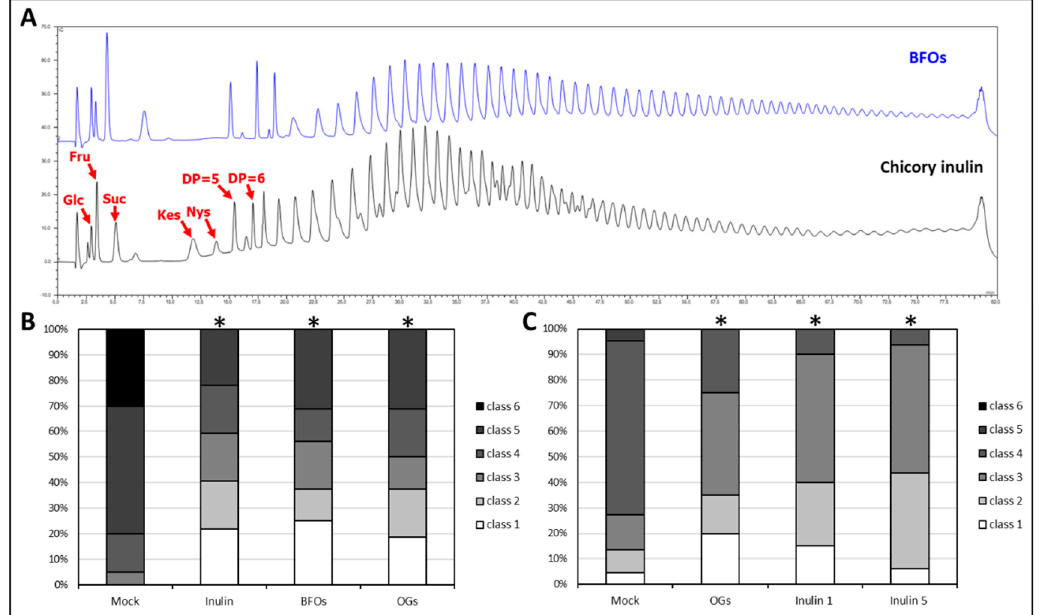
Figure 3. ( A ) Comparison between chromatograms resulting from injection of BFOs and chicory inulin (HPAEC-IPAD). Y axis = detector response in nanoCoulomb; X axis = elution time in min; Glc = glucose; Fru = fructose; Suc = sucrose; Kes = 1-kestose; Nys = nystose; ( B ) Results of the disease scoring experiment comparing BFOs and chicory inulin priming efficiency. Asterisks indicate significance against mock (water) at p < 0.01 according to non-parametrical, two-tailed, Mann–Whitney u -test. This experiment was repeated three times with consistent results; ( C ) Results of the disease scoring experiment comparing chicory inulin at 1 g·L − 1 (inulin 1) and the same solution at 5 g·L − 1 (inulin 5) priming efficiency. Asterisks indicate significance against mock at p < 0.01 according to Mann–Whitney u -test. This experiment was repeated three times with consistent results.